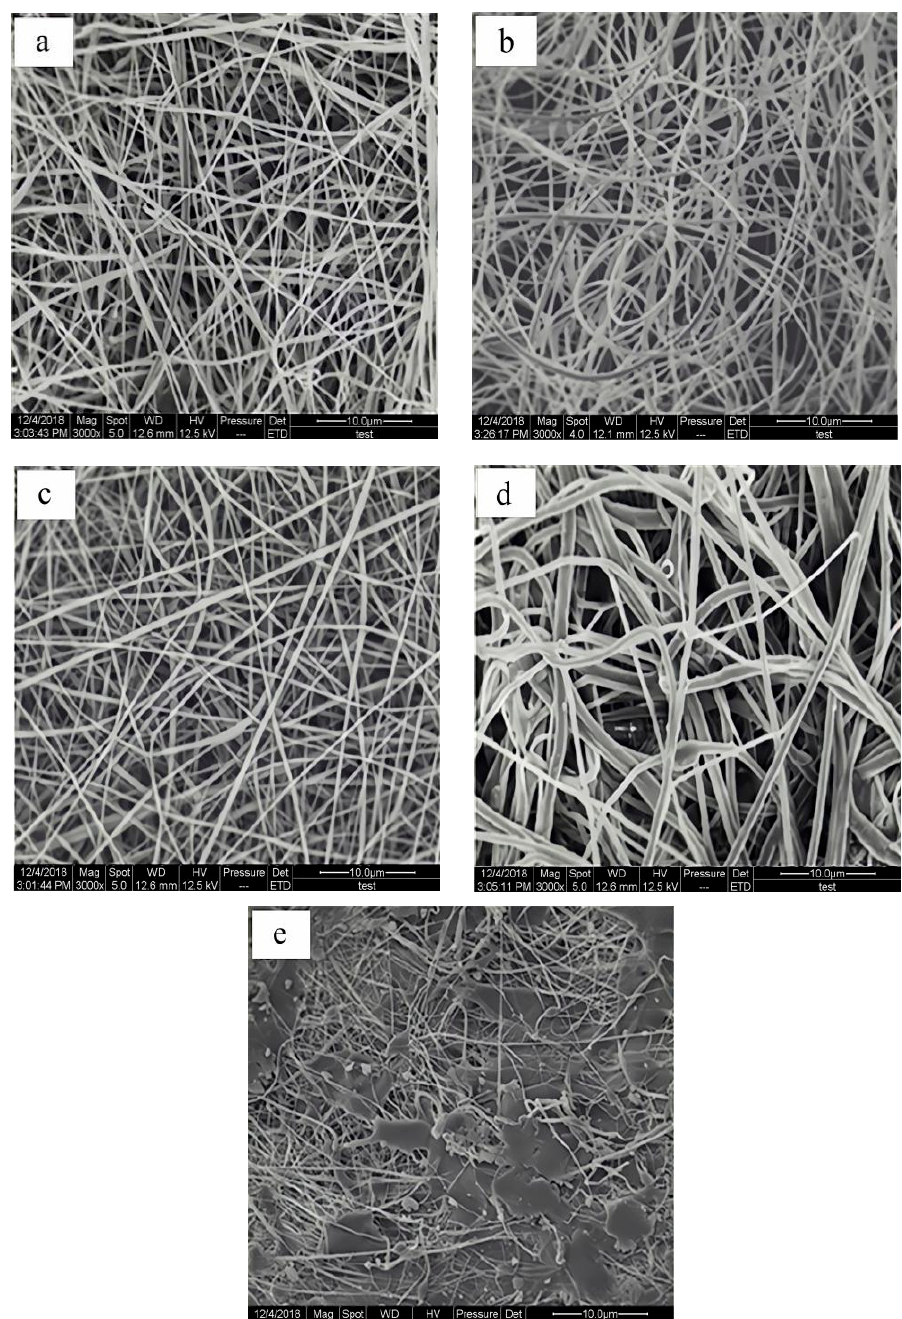
Figure 18. SEM images at different addition of nanographene: ( a ) the addition of 0.5 wt%; ( b ) the addition of 1.0 wt%; ( c ) the addition of 1.5 wt%; ( d ) the addition of 2.0 wt%; ( e ) 1 wt% unmodified nanographene.